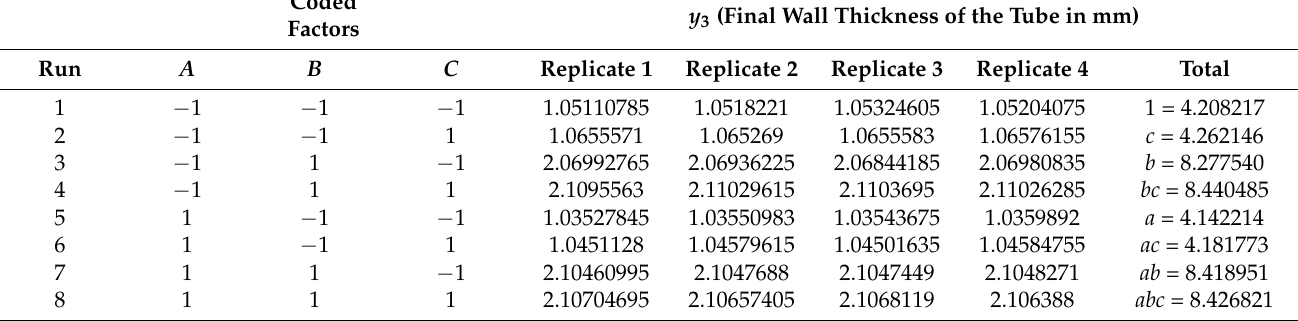
Table 7. General experiment design table for the case of the response variable y 3 (the final wall